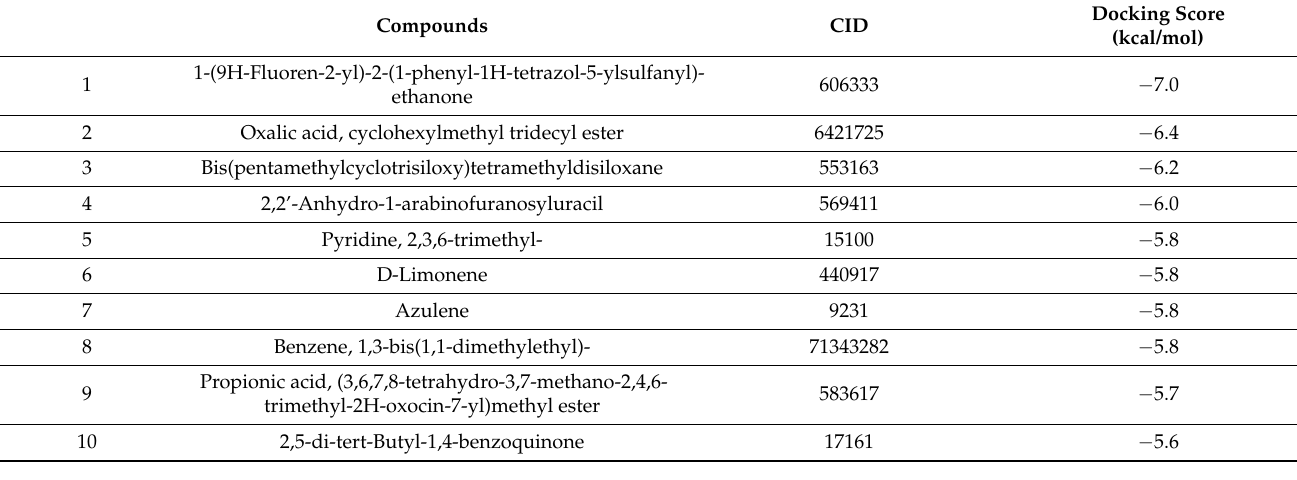
Table 2. Ligand No, PubChem CID of top 10 molecules based on docking-score binding affinity.